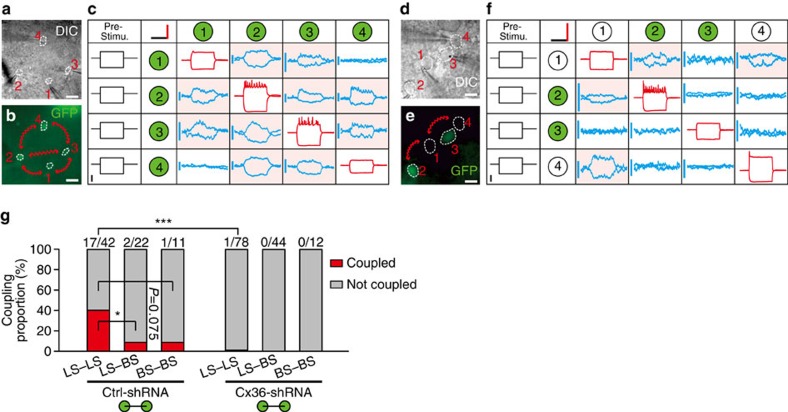
Connexin 36 is required for formation of electrical coupling between interneurons in neocortical layer 1.(a,b,d,e) DIC (a,d) and GFP expression (b,e) images of a quadruple recording of four layer 1 interneurons in a Ctrl-shRNA (a,b) and Cx36-shRNA (d,e) neocortical slice. The red arrows indicate reciprocal electrical coupling (b,e). Scale bar, 20 μm (a,b), 40 μm (d,e). (c,f) Sample traces of voltage changes in the four neurons in response to sequential current injection into one of the four neurons in Ctrl-shRNA slices (c) and Cx36-shRNA slices (f). Green circles indicate GFP+ cells, and white circles indicate GFP-negative (GFP−) cells. The average traces are shown in individual table cells at varying scales. Scale bar, 3 mV (blue), 70 mV (red), 200 ms (horizontal, black) and 200 pA (vertical, black). ‘Pre-Stimu.', presynaptic stimulus protocol. (g) Summary of the proportion of electrical coupling observed between layer 1 GFP+ interneurons in Ctrl-shRNA or Cx36-shRNA slices at P9–P25. Green circles indicate GFP+ cells. n=21 mice for Ctrl-shRNA group, 37 mice for Cx36-shRNA group. ***P<0.001, χ2-test, Fisher's exact test.